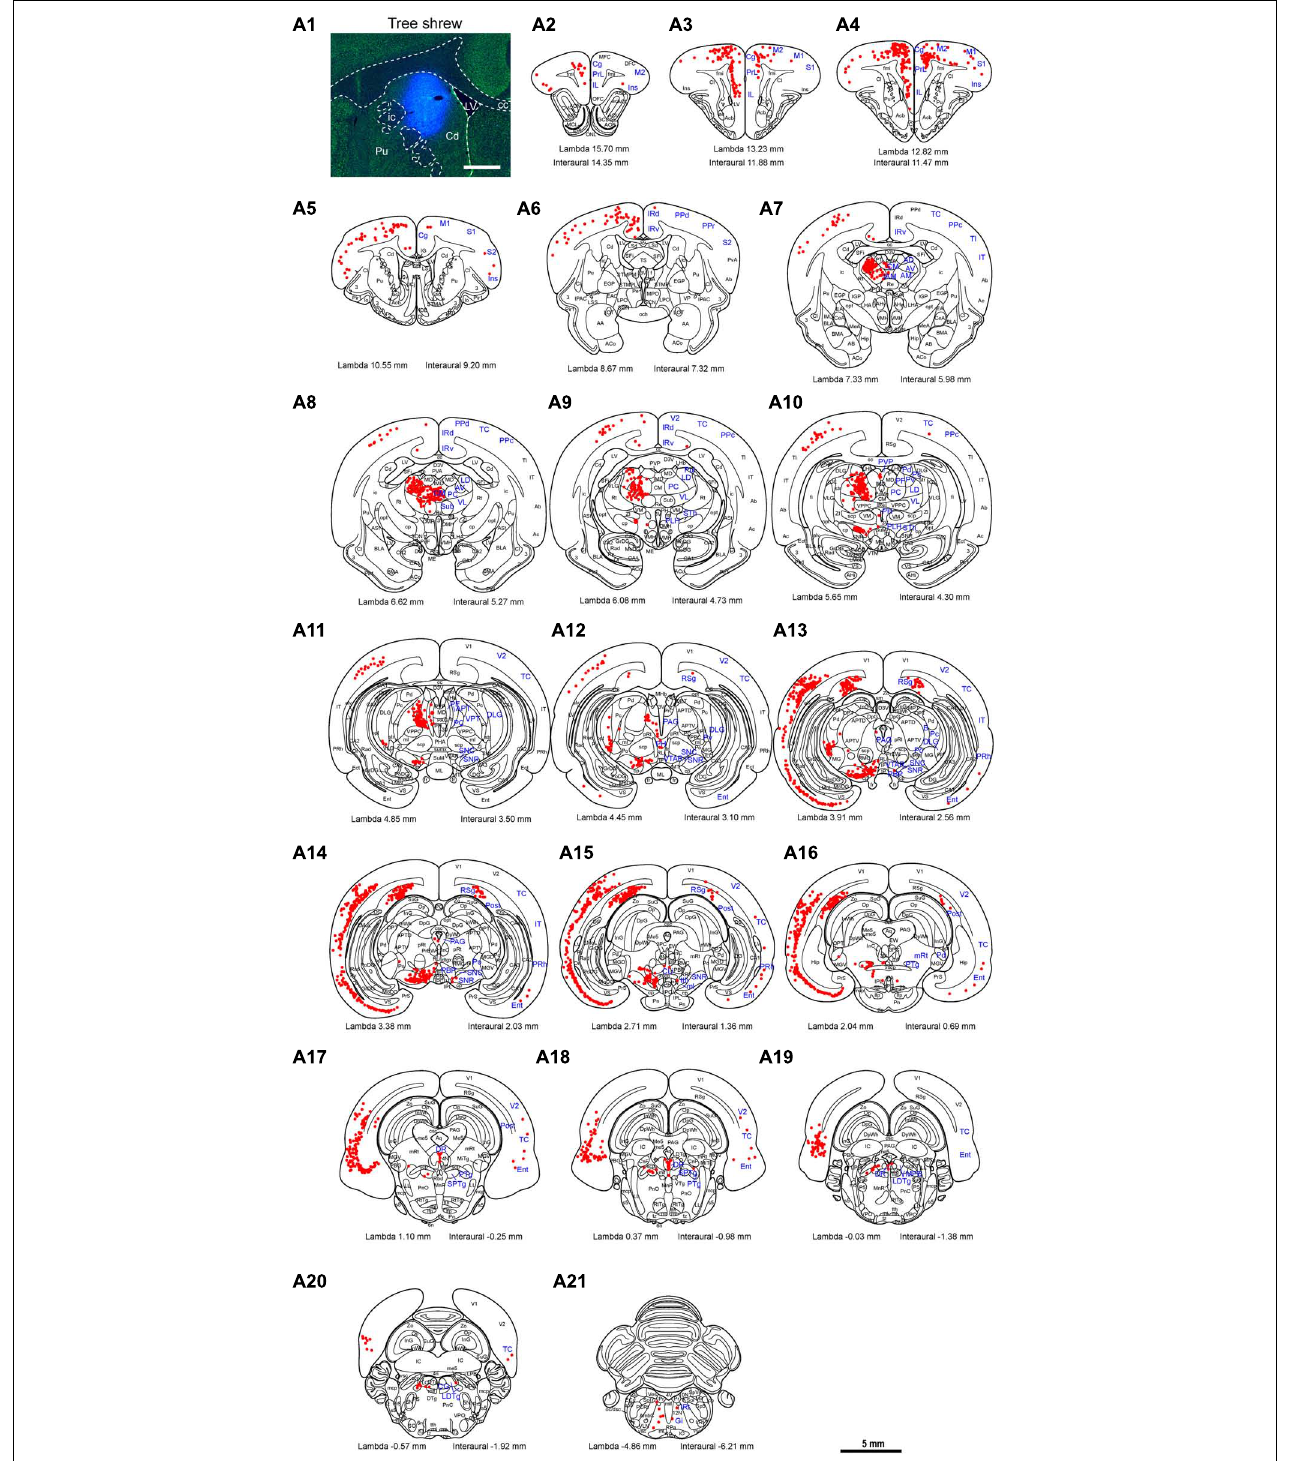
FIGURE 5 | Whole-brain mapping of afferent projections to the caudate nucleus (Cd) in tree shrews. (A1) Unilateral pressure injection of Fluoro-Gold (FG) retrograde tracer (blue) into the Cd of the tree shrew brain. The Cd was determined by staining with NeuroTraceTM 500/525-Green Fluorescent Nissl Stain (green). (A2-A21) Cd-projecting neurons (red dots) were present in the tree shrew brain (blue letters) from rostral to caudal. Representative coronal sections were selected from two tree shrew brains and referenced to lambda (distance indicated at lower left corner). The density of dots represents the relative density of projecting neurons in those areas. Each dot represents approximately one FG-labeled neuron. For abbreviations, see Abbreviations. Scale bars = 1 mm in (A1) ; 5 mm in (A2–A21) .